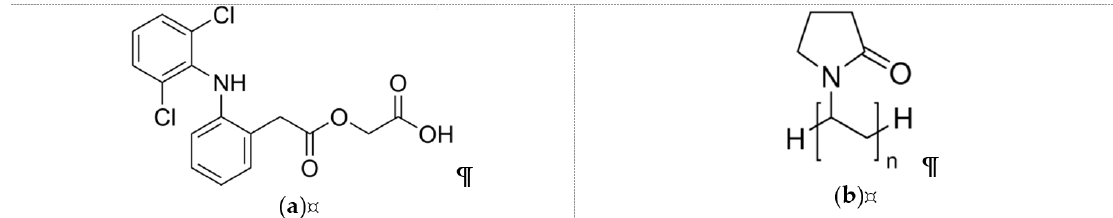
Figure 1. Chemical structures of ( a ) aceclofenac and ( b ) polyvinylpyrrolidone (PVP).